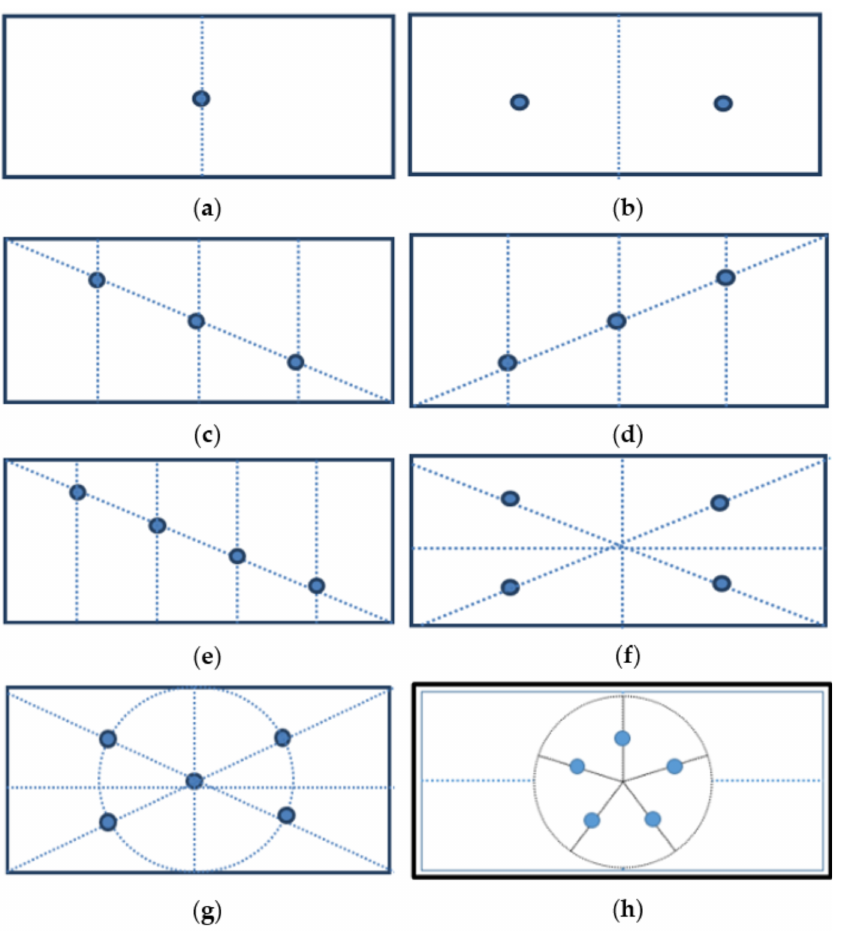
Figure 1. The setting of sampling points. Note: ( a ): 1 sampling point, ( b ): 2 sampling points, ( c ): 3 sampling points, ( d ): 3 sampling points, ( e ): 4 sampling points, ( f ): 4 sampling points, ( g ): 5 sam- pling points, ( h ): 5 sampling